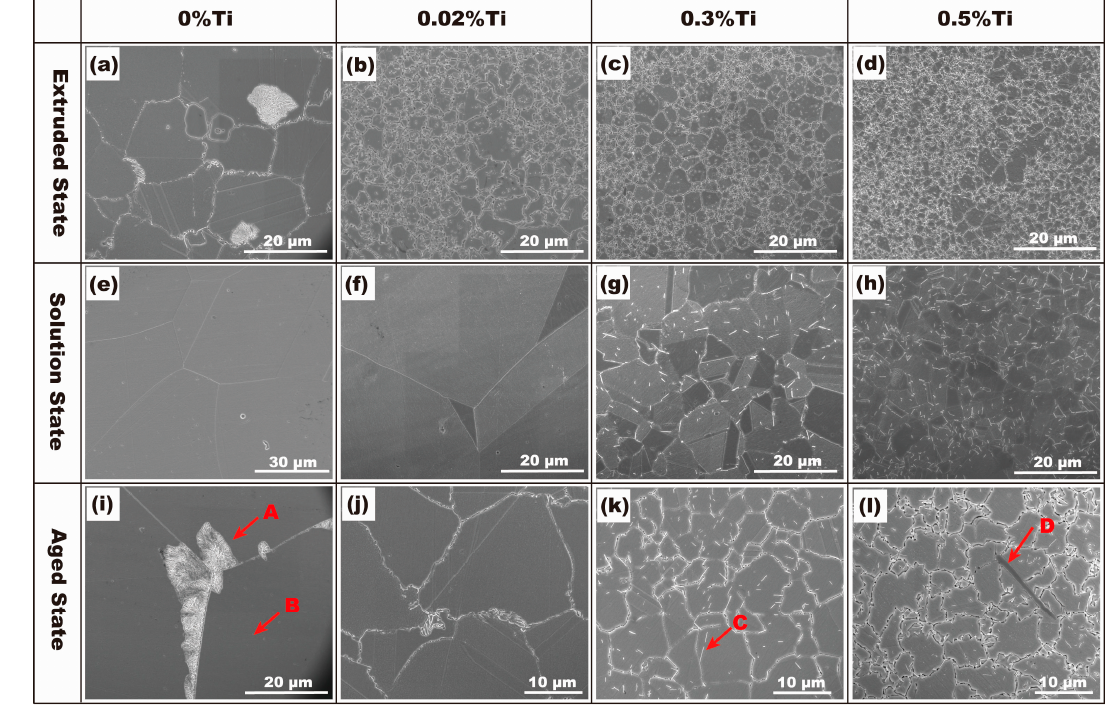
Figure 2. SEM micrographs of alloys with different contents of Ti in different conditions: Figure 2. SEMmicrographsofalloyswithdifferentcontentsofTiindifferentconditions: ( a – d )Hot-extruded state; ( e – h ) Solid solution treatment at 820 ◦ C for 1 h; ( i – l ) Aging treatment at 400 ◦ C for 4 h.